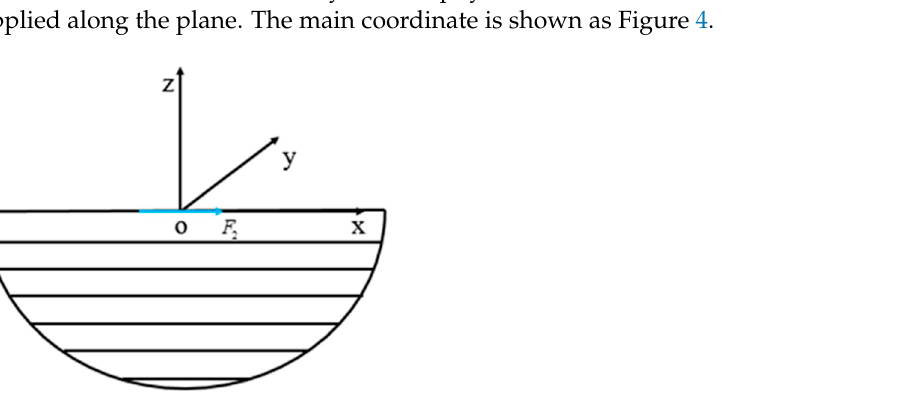
Figure 4. Transversely isotropic elastic half-plane surface subjected to horizontally concentrated stress. The solution process of horizontal stress is the same as that of the vertical stress.